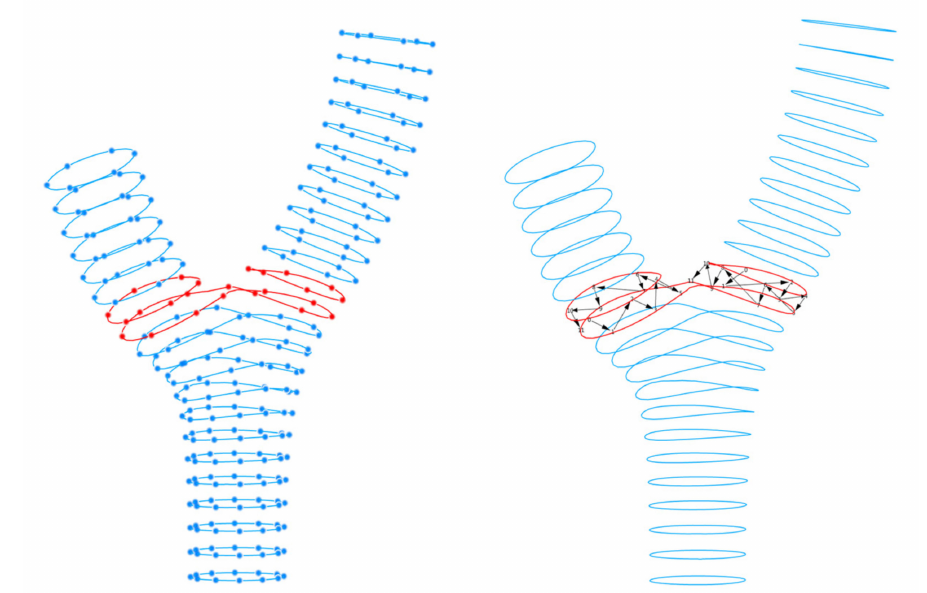
Figure 9. Branch